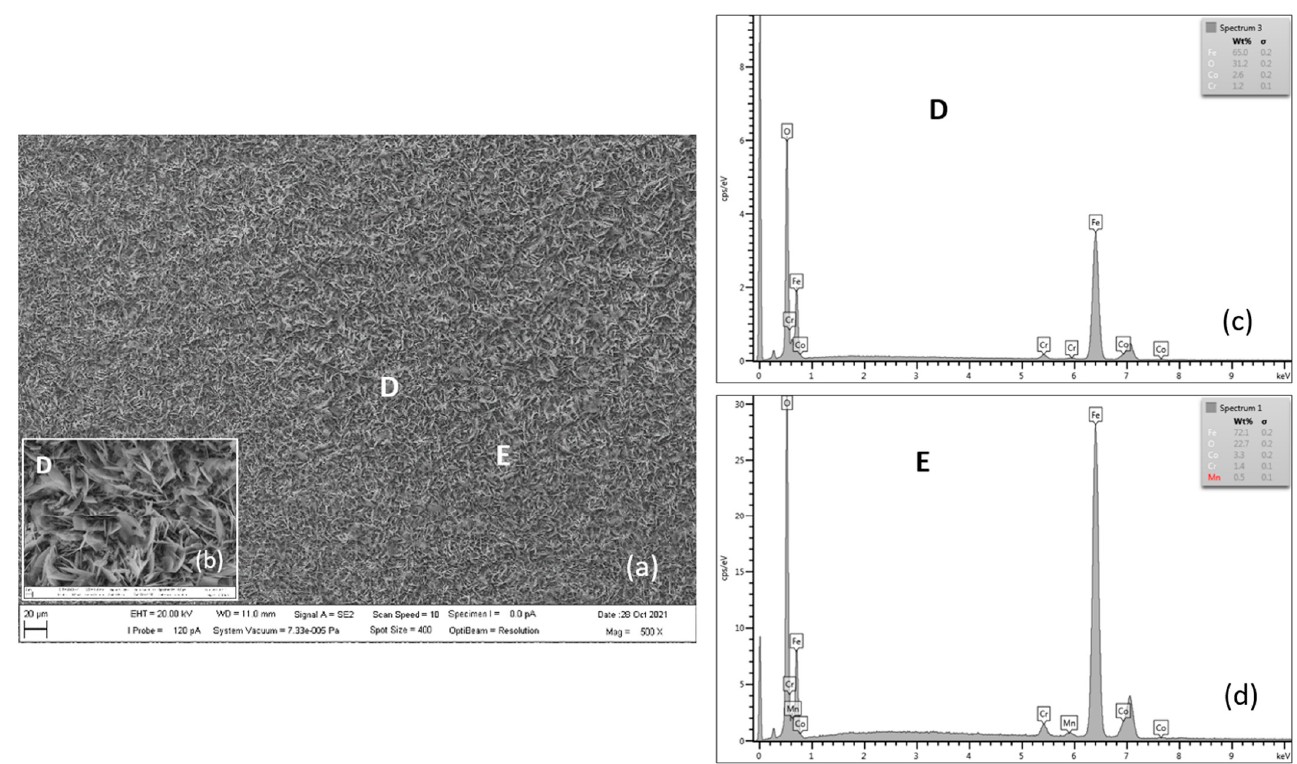
Figure 13. SEM morphology of surface layer of MarBN steel oxidized for 3000 h at 600 °C ( a ), with D location detail ( b ), EDX energy spectrum of steel oxide surface ( c , d ).